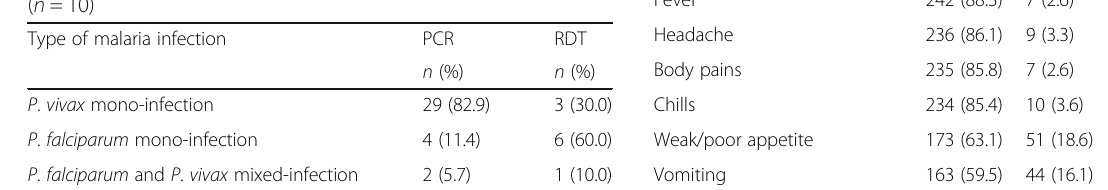
Table 2 Distribution of malaria infection according to species